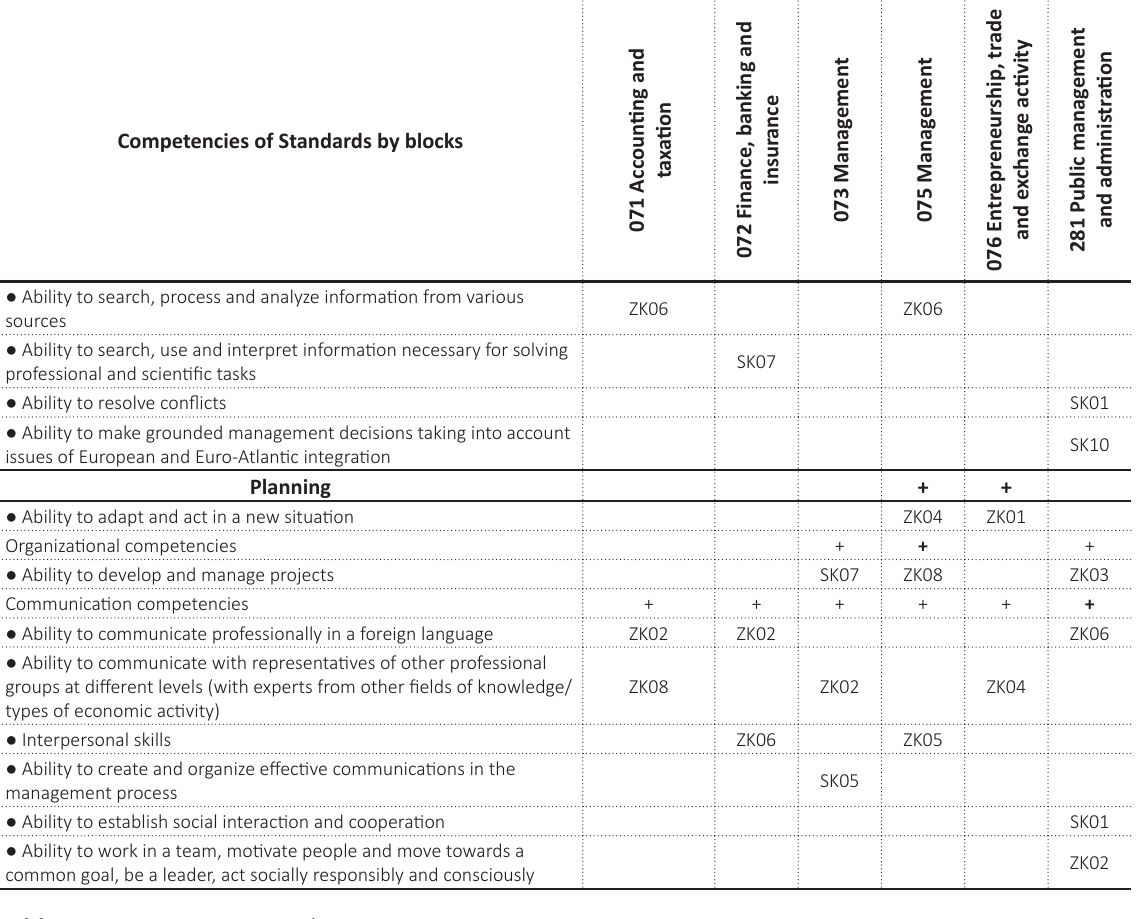
Table A3. Expert survey pool